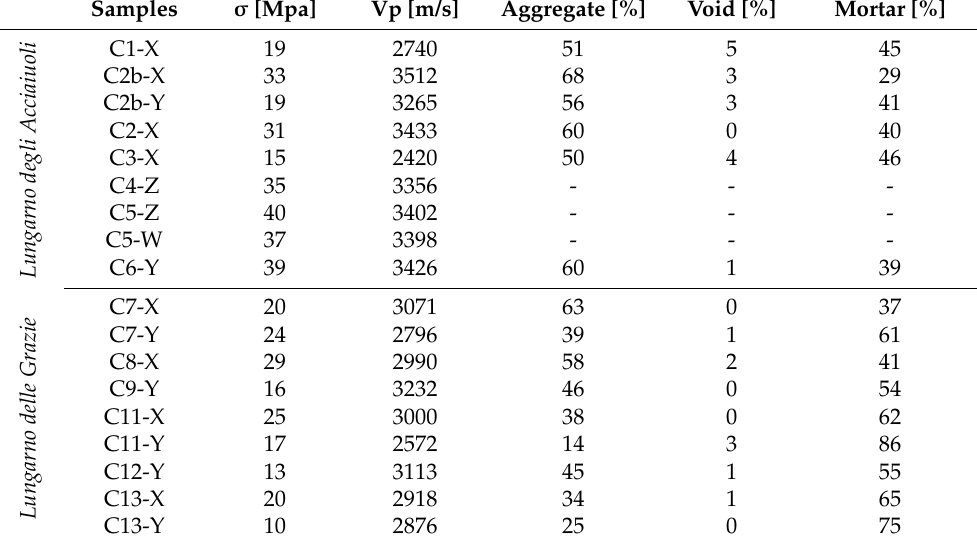
Table 3. Results of mechanical analyses of test